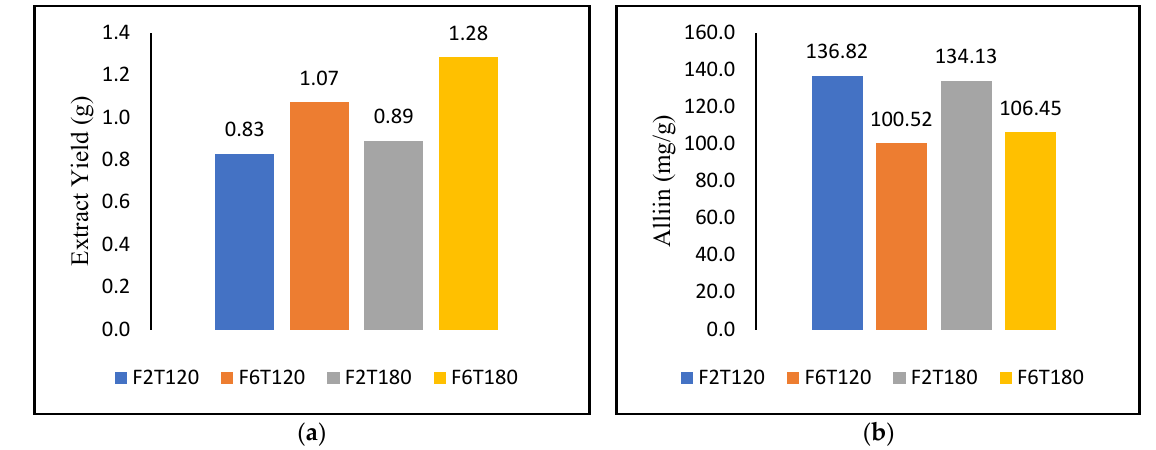
Figure 4. The responses of ( a ) extraction yield and ( b ) alliin using SWE at 2 mL/min and 6 mL/min, 120 °C and 180 °C, and 10 min extraction time.